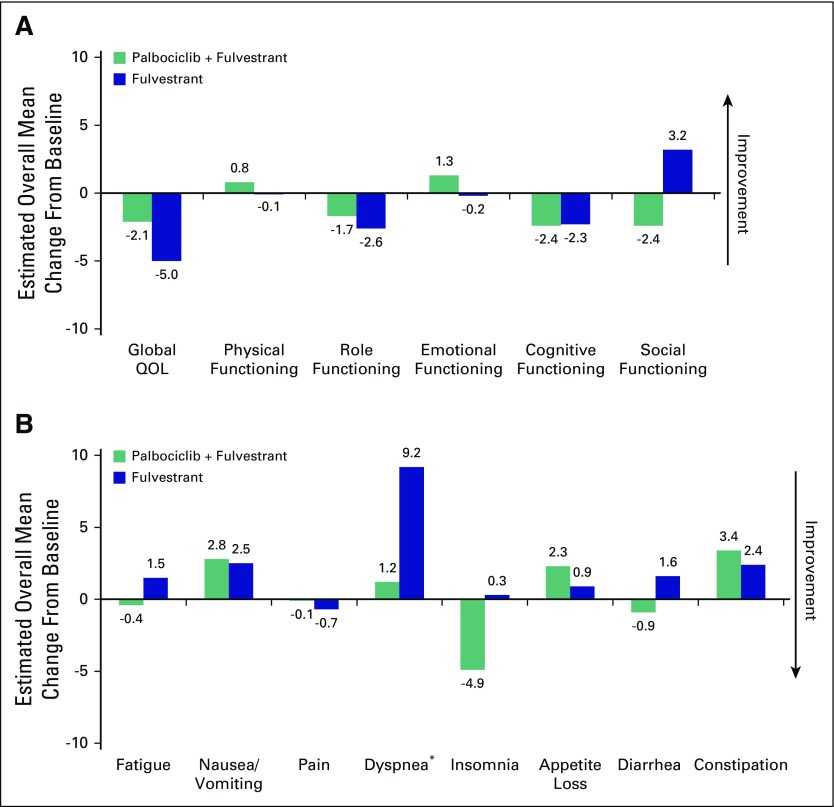
Overall mean (SE) change from baseline in patient-reported scores on the European Organisation for Research and Treatment of Cancer Quality of Life Questionnaire C30 of (A) global quality of life (QOL) and function and (B) symptoms in Asian patients. (*) P < .05 for palbociclib plus fulvestrant versus placebo plus fulvestrant.